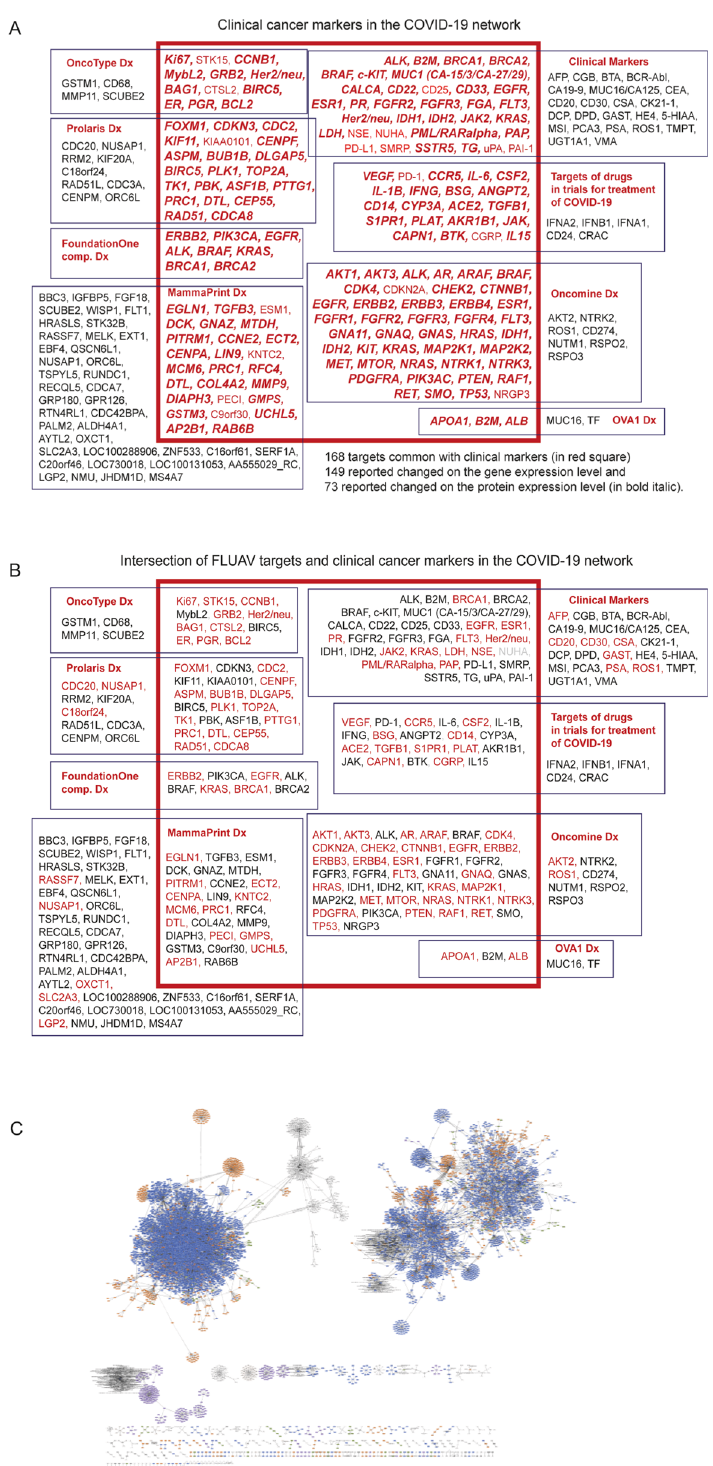
Figure 4. COVID-19 network engages clinically used markers and drug targets. The COVID-19 network was searched for single markers and diagnostic signatures used in clinical practice ( A ). Markers and signatures are annotated in respective boxes. The dark-red box encloses the nodes retrieved from the network. The network of influenza A virus contained a half of the cancer-relevant markers ( B ). The COVID-19-engaged nodes are in bold-red are indicated nodes confirmed by independent transcriptomics and proteomics studies. The structure of the network of influenza A virus is shown in panel C, to illustrate the cluster structure of the network in comparison with the structure of COVID-19 network (Fig. 1). To explore identifiers of the nodes and edges, zoom-in the “NetworkFLUAV01” network in the Supplementary File S1 online at FigShare.com (https ://figsh are. com/artic les/onlin e_resou rce/Cance r_and_COVID -19_syste ms_biolo gy_Suppl _File_S1/12793